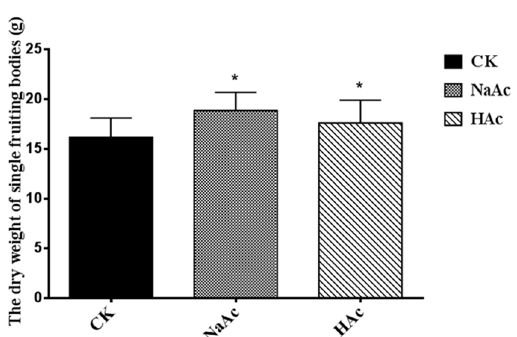
Figure 1. The average dry weights of single fruiting bodies. CK, control check; NaAc, treatment with sodium acetate; HAc, treatment with acetic acid. The error bars indicate the standard deviations from three independent samples. * indicates statistical significance ( p < 0.05) compared to the CK strain.